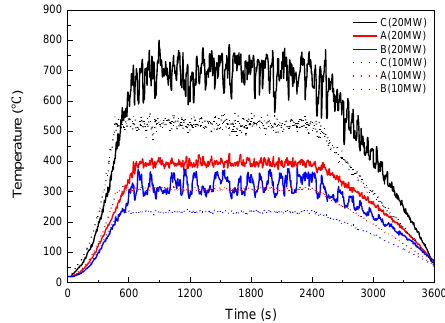
Figure 9. Air temperature at each monitoring point.